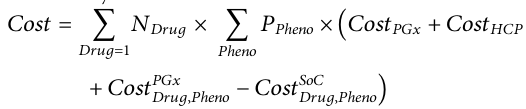
a Clinicalrelevancescore:CTCAE,5(death),asreportedinthesummaryofliteratureunderlyingtheDPWG,recommendations;DGI,drug-geneinteraction;EM,extensivemetabolizer;IM, intermediate metabolizer; PM, poor metabolizer; UM, ultra-rapid metabolizer; DPWG, dutch pharmacogenetics working group, and GAS = gene activity